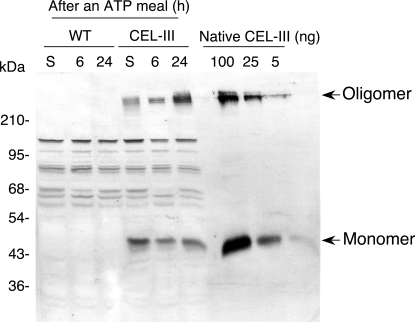
CEL-III Expression in Midguts of Transgenic MosquitoesTransgenic (CEL-III) and non-transgenic (WT) mosquitoes were allowed to feed on naïve mice. After 6 or 24 h, midguts of engorged mosquitoes were dissected and lysed, then electrophoresed on 8% SDS-PAGE. As a control, midguts of sugar-fed mosquitoes (S) were dissected and lysed. CEL-III expression level was examined by western blotting using mouse anti-CEL-III antiserum. Each lane contains protein lysates equivalent to two midguts. The source of protein is indicated at the top of each lane (6, 24 h). For quantitative estimation of CEL-III per midgut, native CEL-III isolated from C. echinata body fluid was analyzed by western blotting. The amount of native CEL-III (5, 25, 100 ng) is indicated at the top of each lane. Arrows indicate the positions of monomeric and oligomeric forms of CEL-III.